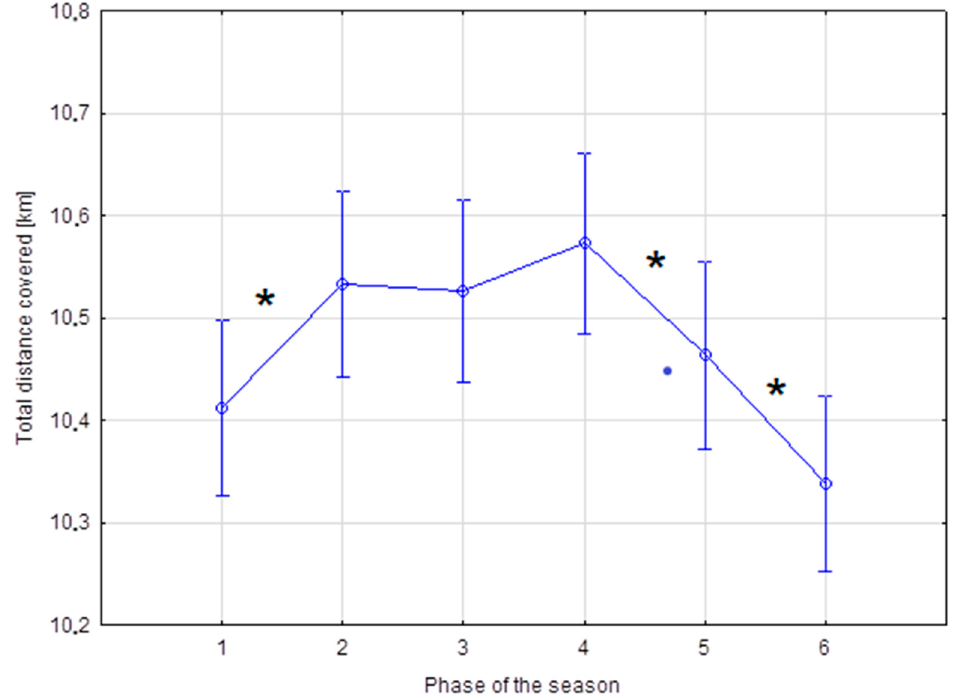
Figure 1. Total distance covered [km] in successive phases of the Bundesliga season. * Statistically significant difference ( p ≤ 0.05).